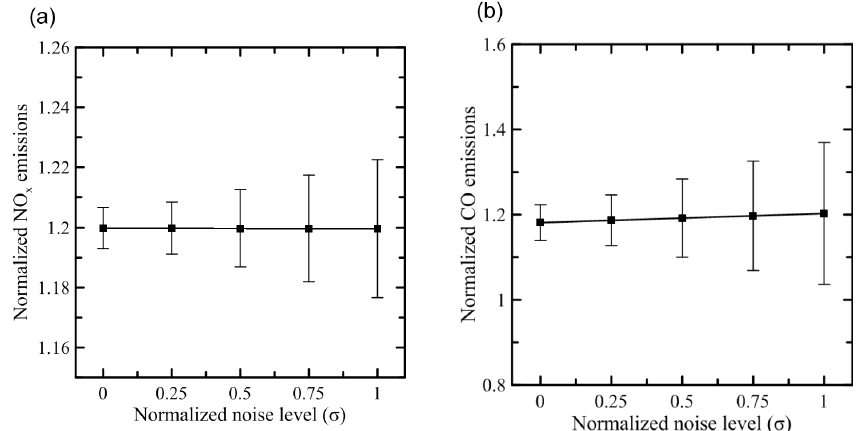
Figure 8. The total NO x (a) and CO (b) emission estimates ( ˆ E s tot ) obtained in the OSSEs where the “true” emissions were specified by scaling the bottom-up emissions (employed in the base case model run) with the factor of 1.2. The emission estimates (normalized to the respective bottom-up emission estimates, e E s tot , based on the EMEP inventory data) represent the average over the ensemble of 100 Monte Carlo experiments, each with a different sample of noise in the synthetic data, and are shown as a function the noise level ( σ) . Both non- diagonal elements of the error co-variance matrix and the systematic uncertainties were taken into account in the OSSEs (specifically, both ξ and δ were set to be equal to unity; see further details in Sect. 3.5). Note that the value of 1.2 on the axis of ordinates corresponds to a perfect emission estimate in the case considered. Note also that the confidence intervals shown were estimated by using the subsampling technique (see Eq. 12) that is expected to predict a nonzero uncertainty (associated with the bias estimation procedure) even when the synthetic input data are not affected by random uncertainties (that is, when σ = 0; see also blue lines in Fig. 7).